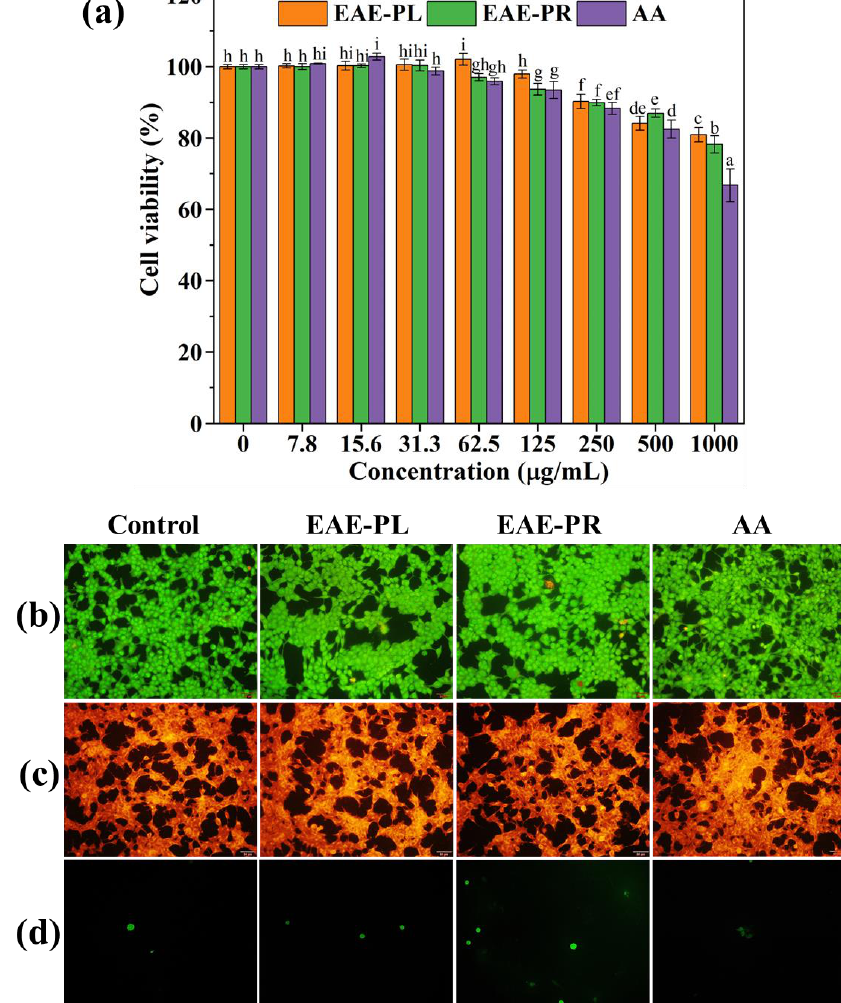
Figure 2. Cell viability analysis of HEK-293 cells against the EAE-PL and EAE-PR using an MTT assay ( a ) and a florescent staining assay ( b – d ), where the AO/EB dual staining ( b ), Rh-123 ( c ), and DCFH-DA ( d ) staining examinations were performed with a 50 µ m scale bar. Error bars represent the SD of 3 independent experiments, and superscripts on error bars represent significance ( p < 0.05) among the